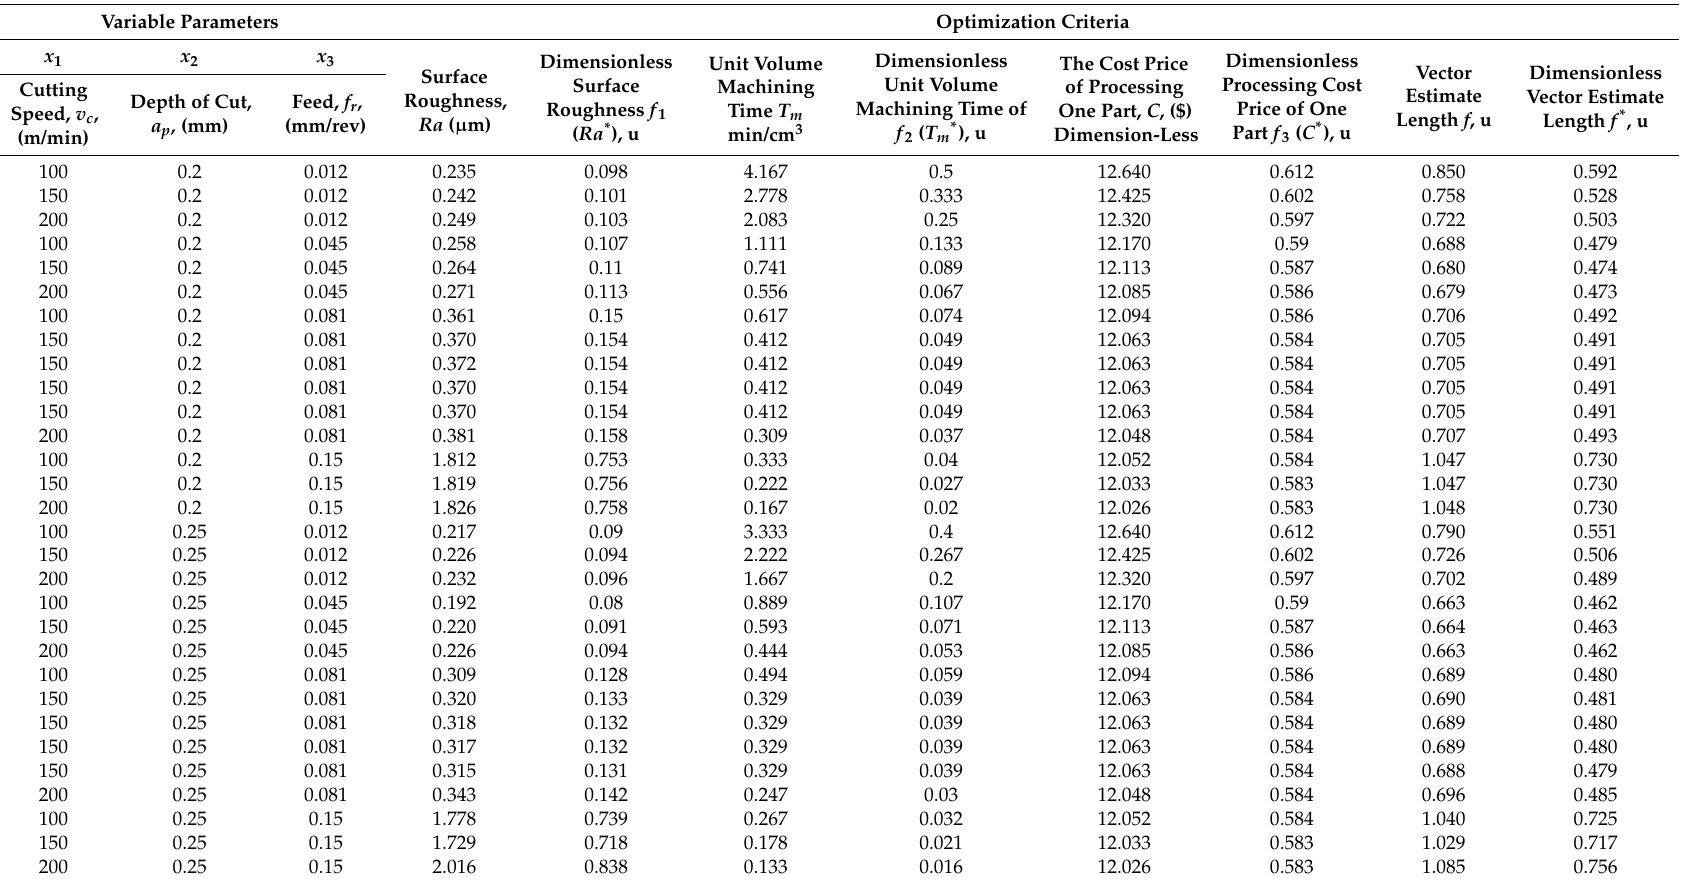
Table 6. A selection of the optimization criteria parameter value set for the variable parameters of machining an ECAP-2 hardened